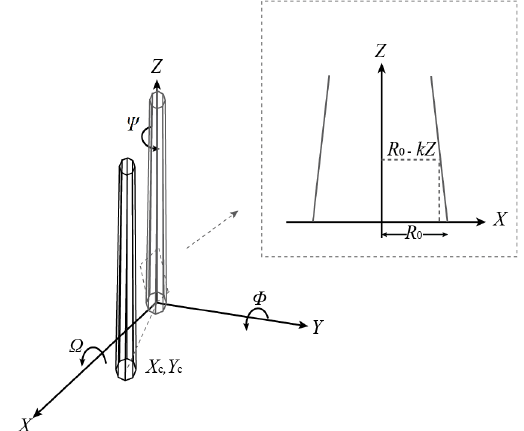
( R ) at Z = 0 and also the cone gradient factor ( k ) as depicted in 0 Figure 1. Some of the parameters are inherited from the conventional cylindrical model which has five degrees of freedom (Rabbani et al., 2007). The octagonal cone has one additional rotation parameter ( Ψ ) about the Z-axis on the top of the cylindrical model because an octagon is not isotropic about the Z-axis.